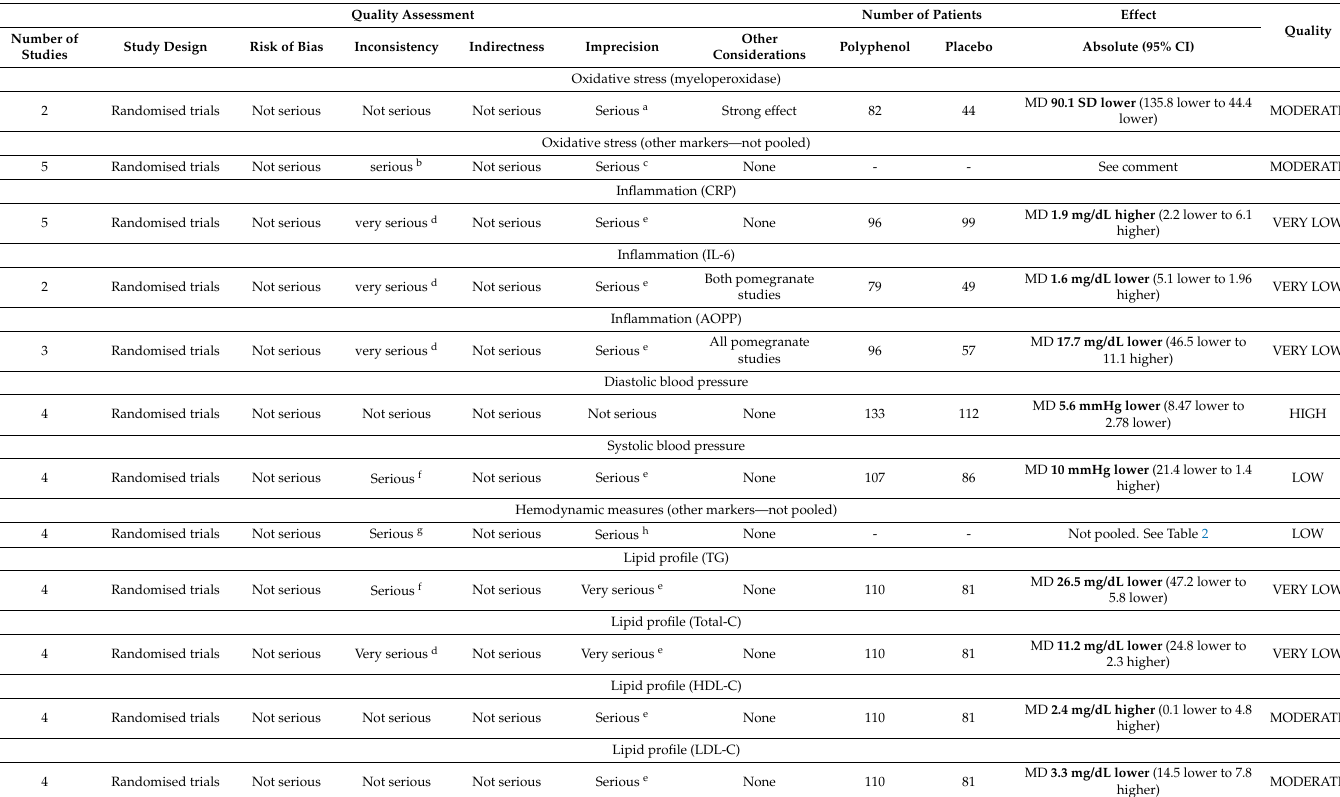
Table 3. Grading of Recommendations, Assessment, Development and Evaluation (GRADE) assessment of polyphenol supplementation compared to placebo for improving cardiovascular risk factors in haemodialysis